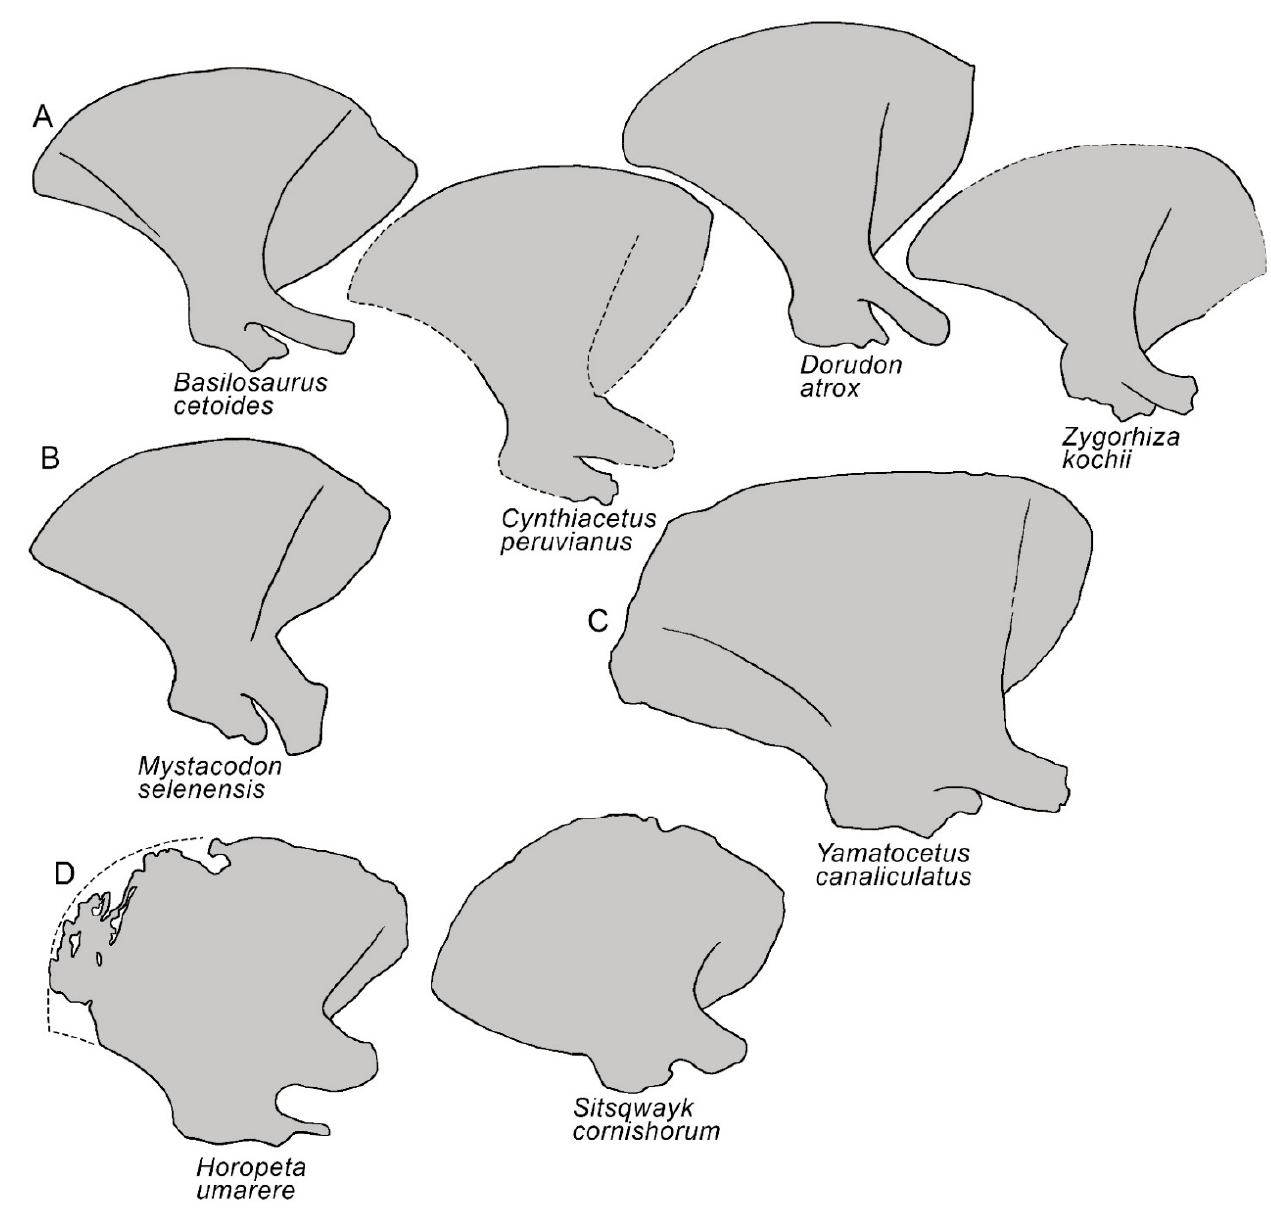
Figure 20. Scapulae of archaeocete and nonbalaenomorph mysticetes. ( A ) Archaeocetes. ( B ) Mystacodon selenensis . ( C ) The eomysticetid Eomysticetus whitmorei . ( D ) Stem-Balaenomorpha. Not to scale. The scapulae are represented as if they shared the same anteroposterior length.